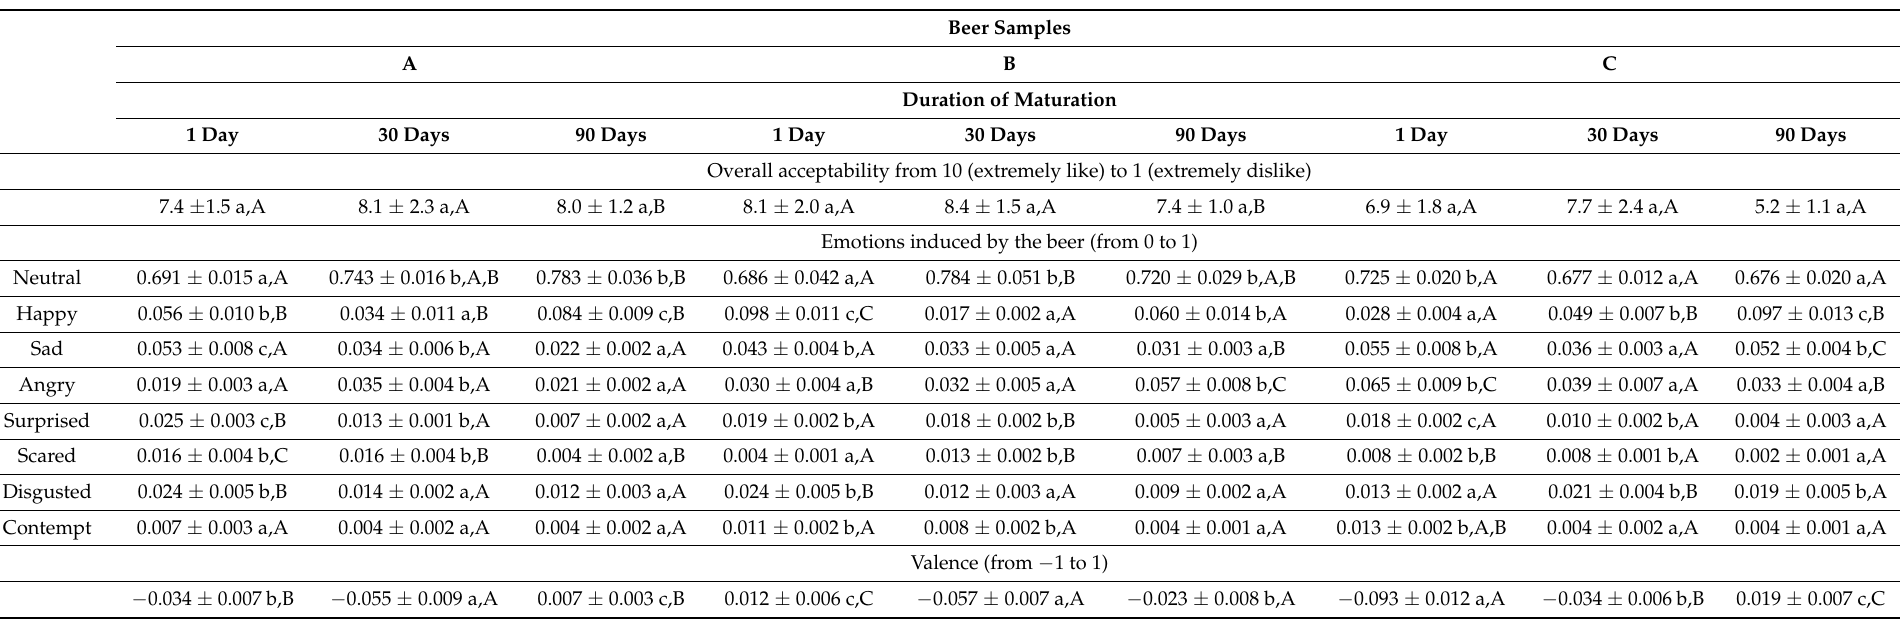
Table 2. Overall acceptability and emotions induced for consumers by beer samples (A—beer fermented with Saccharomyces cerevisiae var. diastaticus ; B—beer fermented with Saccharomyces cerevisiae var. bayanus ; C—beer fermented with Brettanomyces claussenii